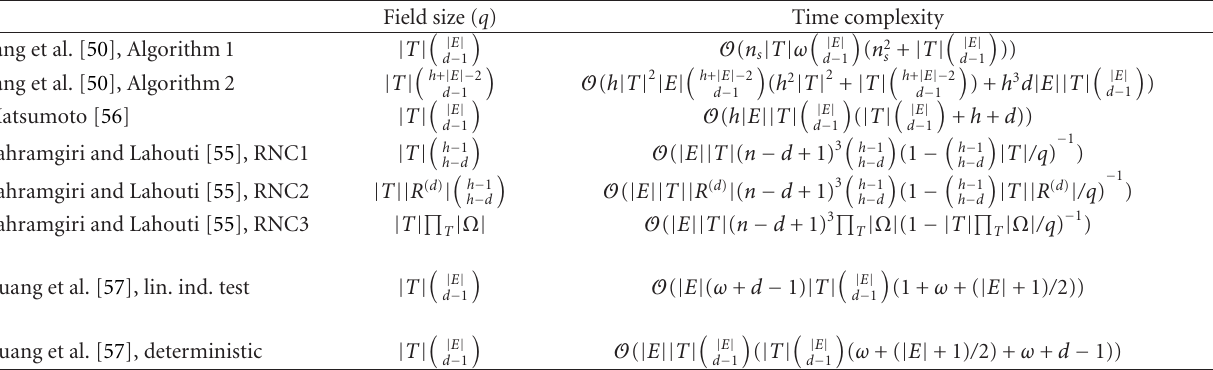
Table 4: Comparison of centralized algorithms for single-source multicast network error correction code construction. | E | is the total number of edges in the network, | T | the number of sinks, d is the minimum distance at all sinks, h is the multicast rate, n s the number of outgoing channels from the source. In Bahramgiri and Lahouti’s algorithms: R ( d ) is the set of failure patterns with at most d − 1 failures of edges in common with other paths, Ω includes all possible sets of paths